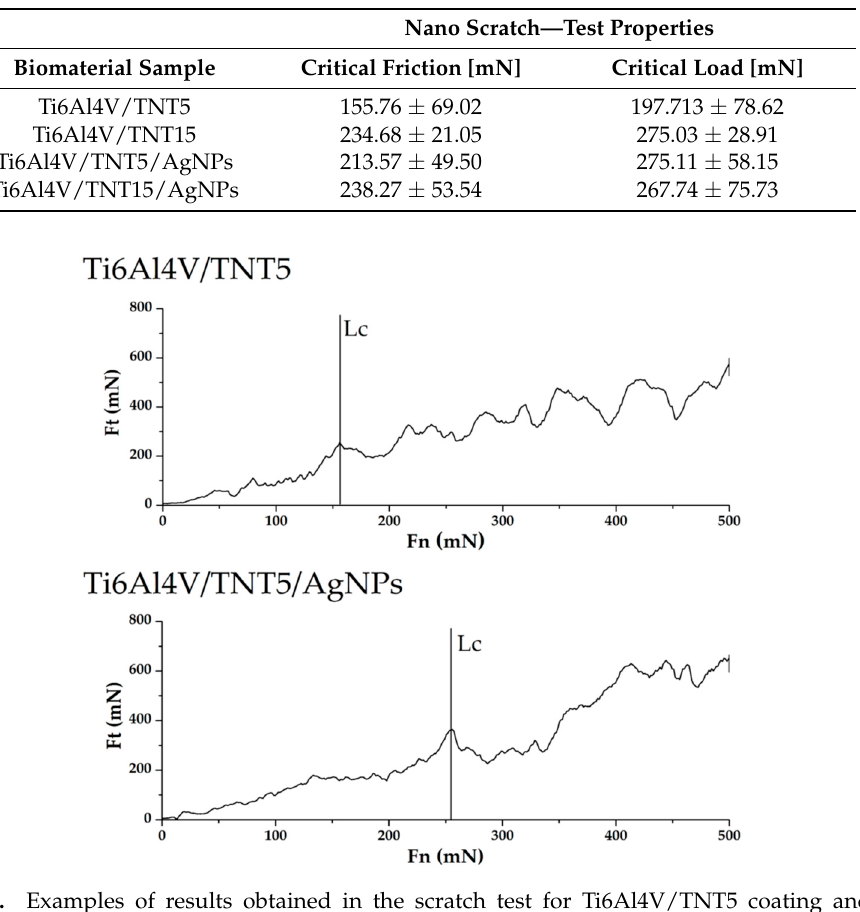
Figure 7. Examples of results obtained in the scratch test for Ti6Al4V/TNT5 coating and for Ti6Al4V/TNT5/AgNPs composite.